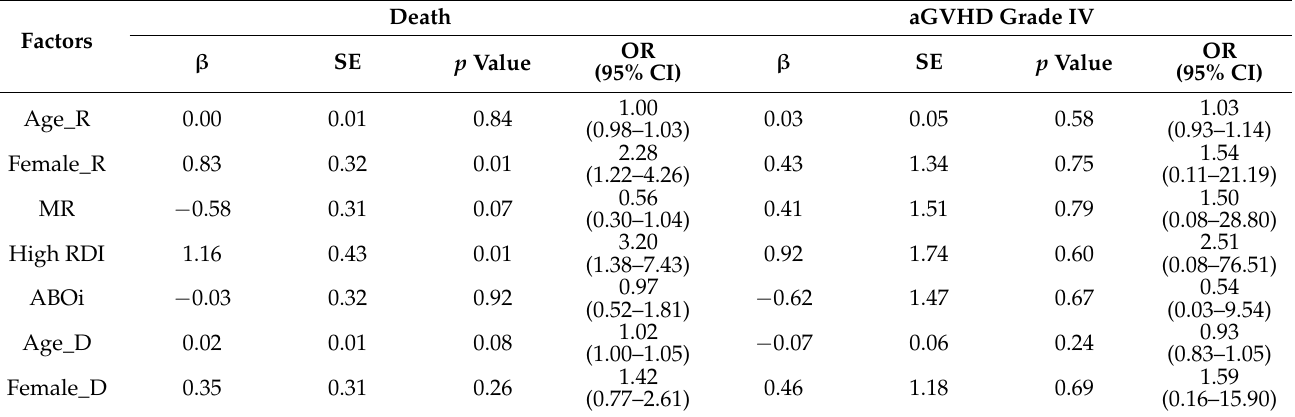
Table 3. Risk factors for death and aGVHD grade IV, determined using the Cox proportional hazards